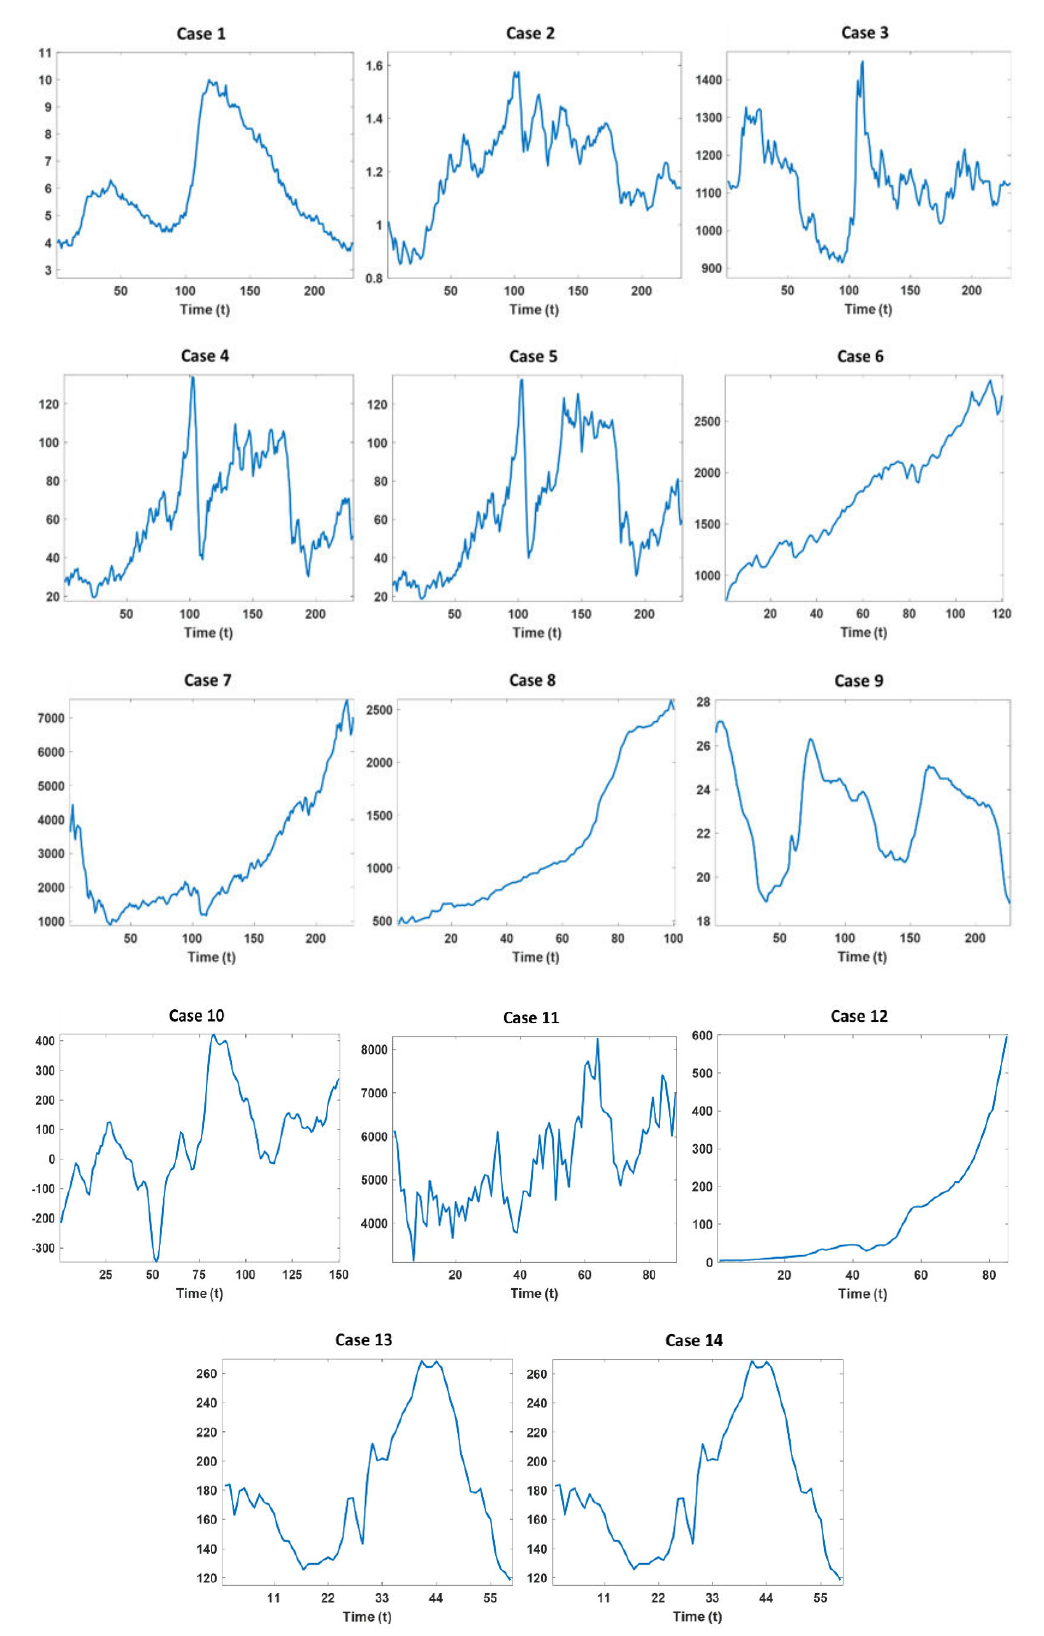
Figure 6. Time series data of 14 real